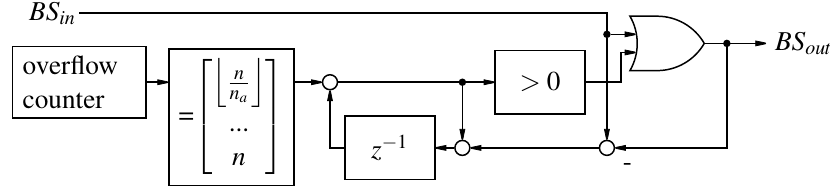
Figure 9. Control system for adding a fixed value to a